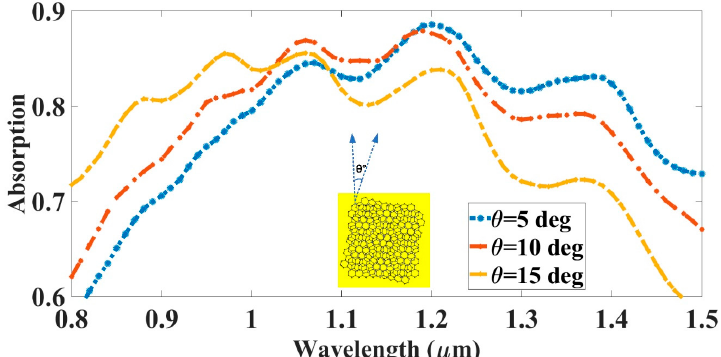
Table 1. Tuning using twist angles. Figure 6. Comparison of absorption responses for three different twist angles ( θ ): 5 ◦ , 10 ◦ , and 15 ◦ . The tuning of the spectrum and wavelength peak is visible in the plot. The wavelength range is observed from 0.8 µm to 1.5 µm. The absorption is higher than 60% for the whole wavelength range.